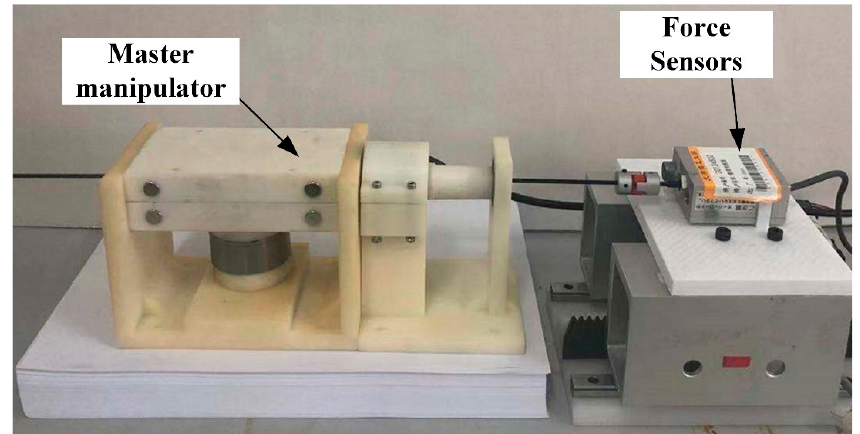
Figure 13. Experimental setup.